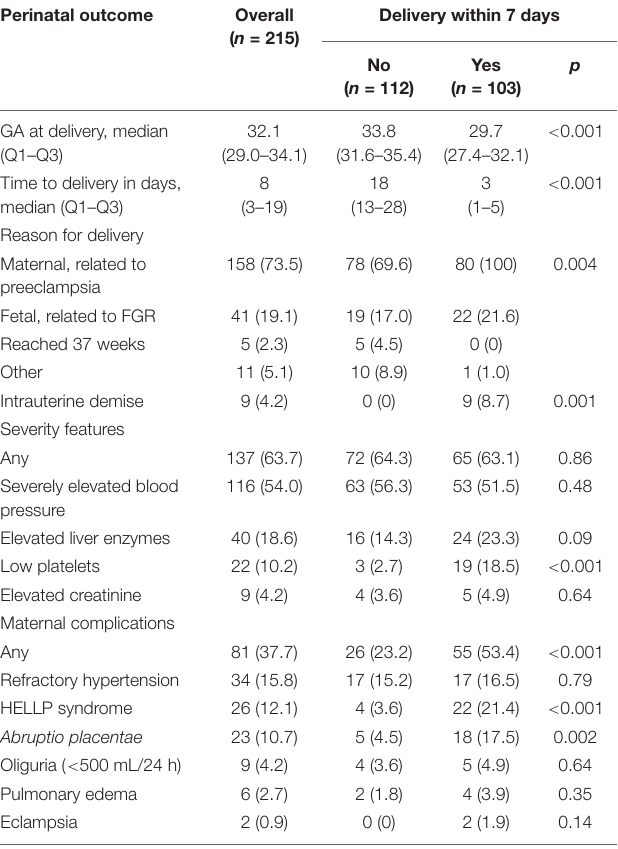
TABLE 3 | Maternal and perinatal outcomes stratified by the presence of preeclampsia complications within 7 days of diagnosis. Perinatal outcome Overall ( n = 215)